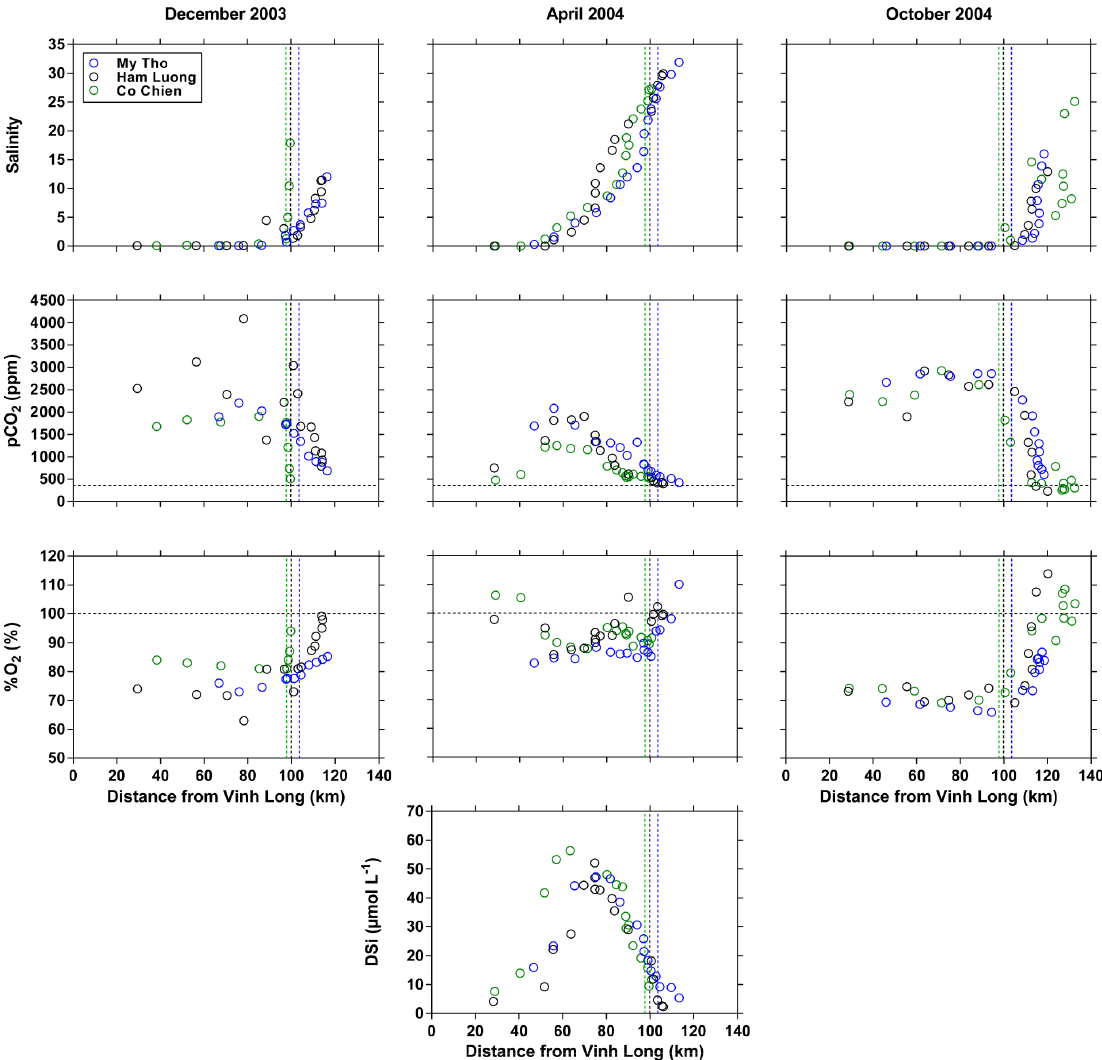
Figure 3. Distribution as a function of distance downstream of the city of V˜ınh Long of salinity, partial pressure of CO 2 (pCO 2 , ppm), oxygen saturation level (%O 2 , %), and dissolved silica (DSi, µmolL − 1 ) in the three branches of the Mekong delta (M e y Tho, Hàm Luông, and C ´ˆ o Chiên) in December 2003, April 2004, and October 2004. The vertical dotted lines indicate the location of the river